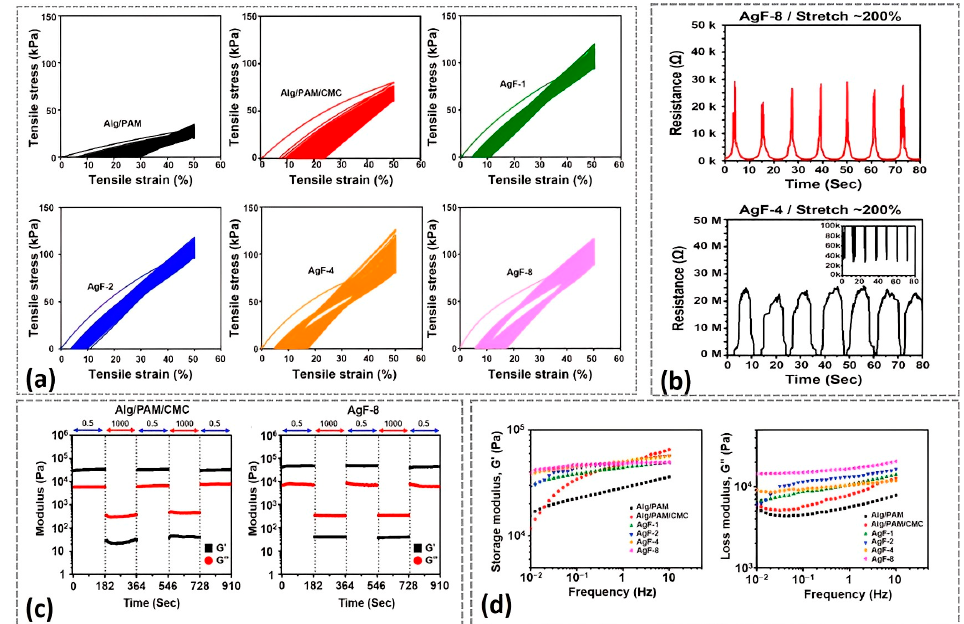
Figure 7. Mechanical, rheological, and electrical characteristics of CMC-based hydrogels. ( a ) Stress– strain curves of CMC-based hydrogels. ( b ) Resistance of CMC-based hydrogels at 200% stretch percentage against time. ( c ) Modulus vs. time curve for CMC-based hydrogels. ( d ) Oscillation frequency sweep curve of CMC-based hydrogels. Re-printed from an open access article under the terms of Creative Commons A tt ribution 4.0 International License of Ref. [121].